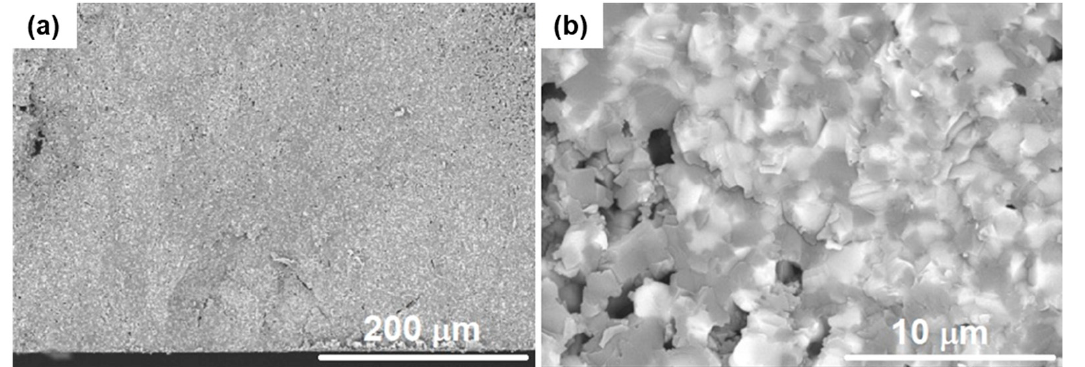
Figure 8. Characteristic fracture surface of the CZM-2A composite at ( a ) low magnification (250×), and ( b ) high magnification (5000×).